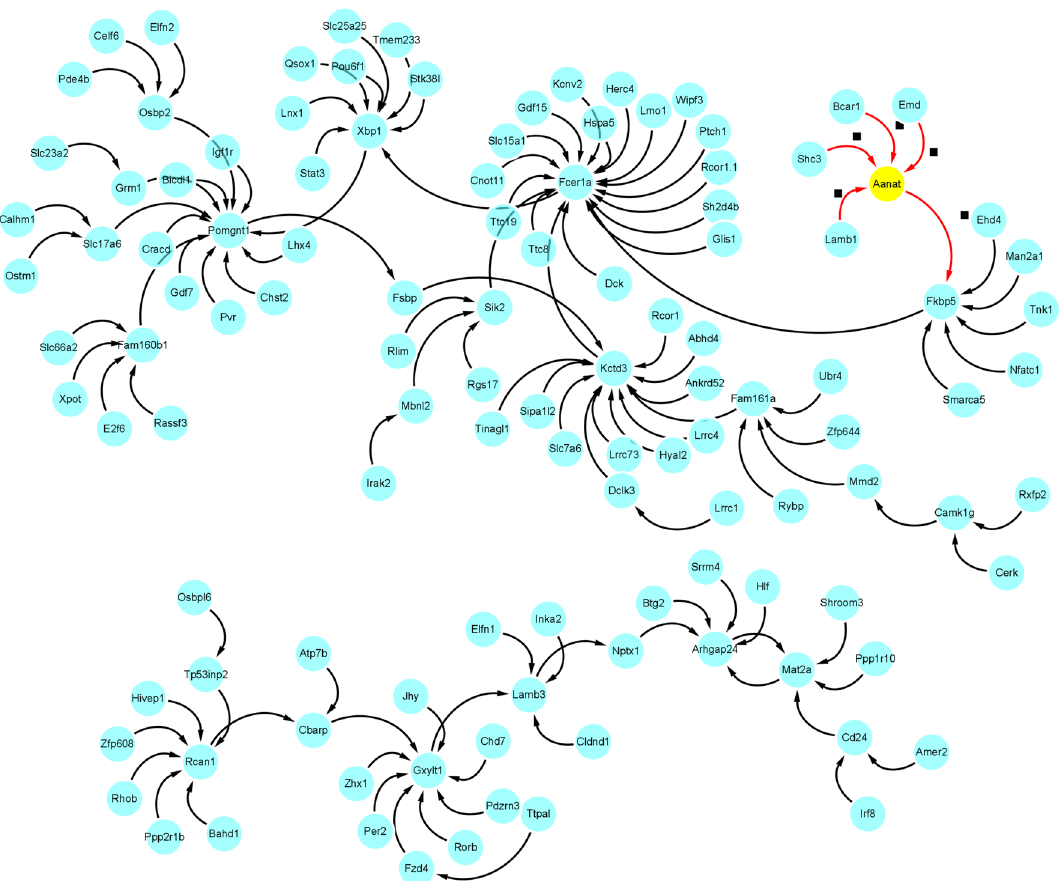
Figure 14. The gene regulatory